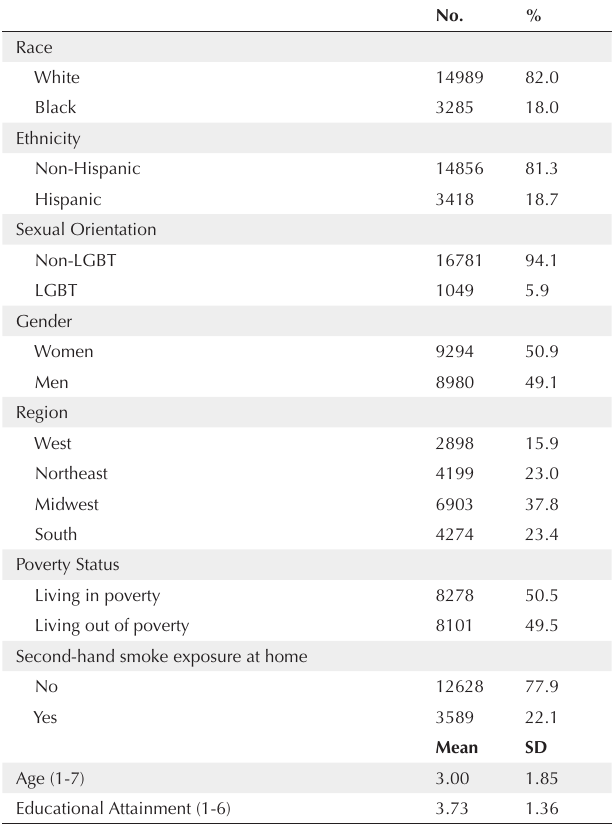
Table 1. Descriptive Statistics of the Overall Sample (n = 18,274)